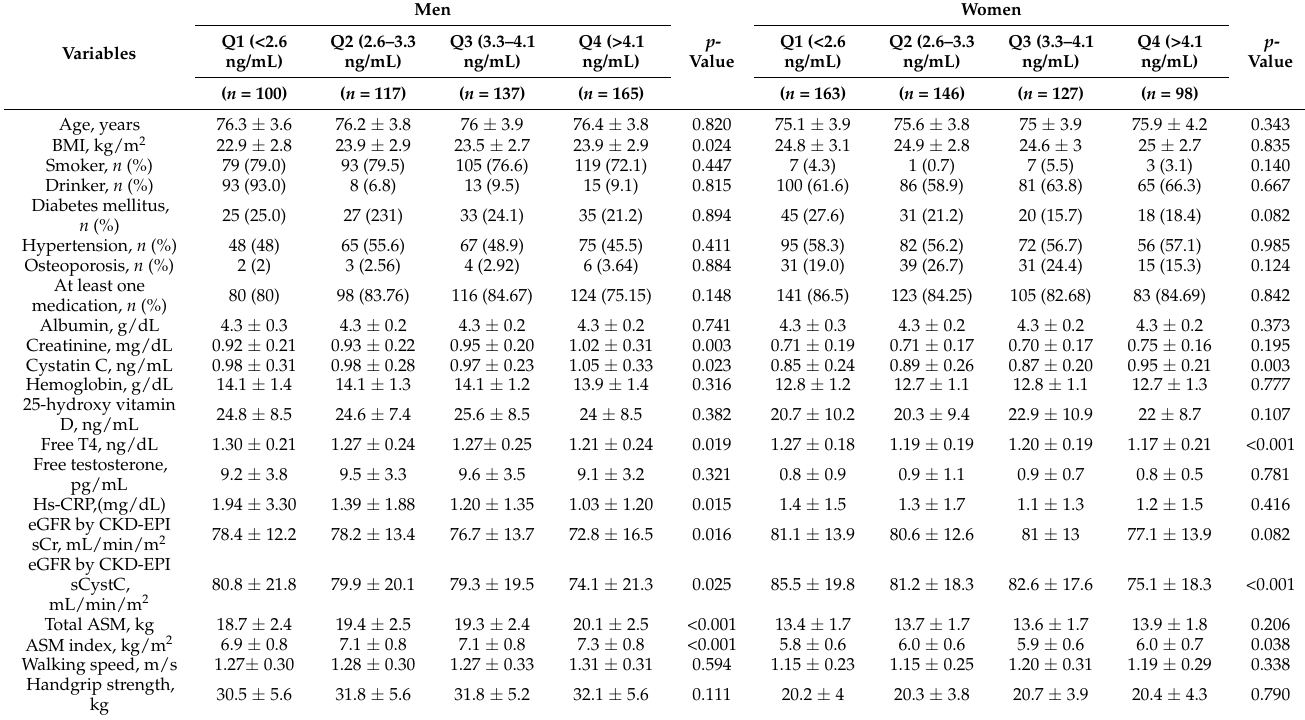
Table 1. Characteristics according to serum myostatin level quartiles in 519 men and 534